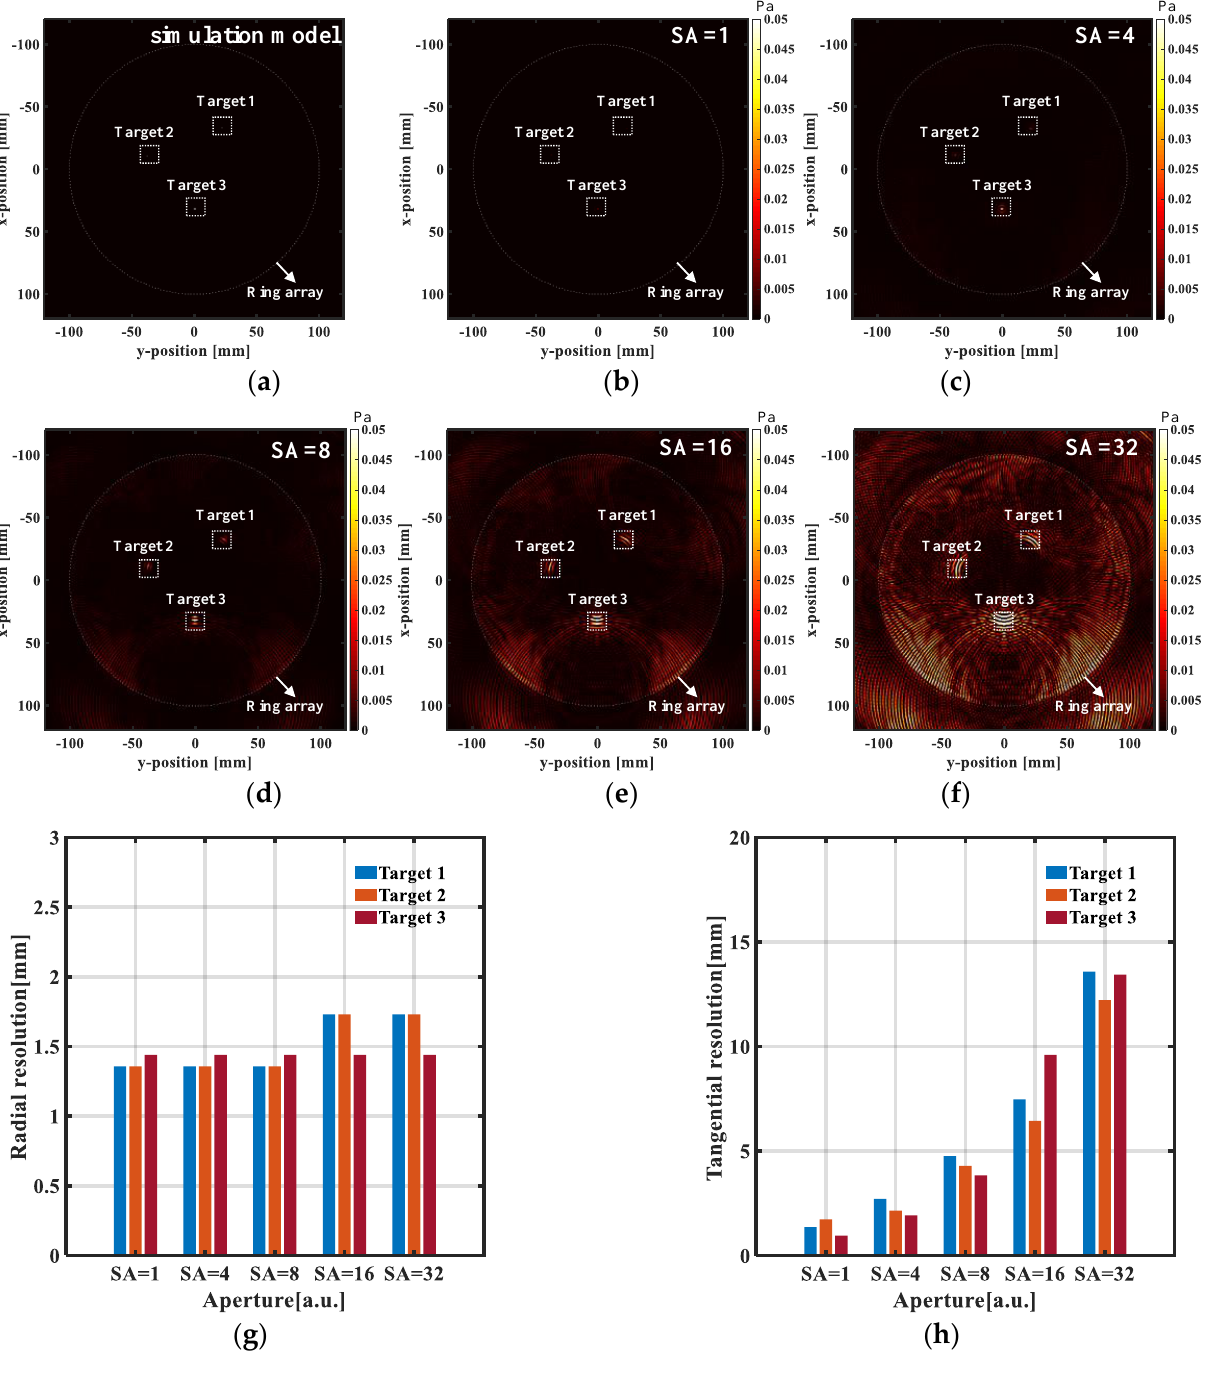
Figure 5. Simulation of the point target with a different aperture (SA = 1, 4, 8, 16, 32). ( a ) Three different targets are built in the simulation model, Target 1 with a radius of 0.25 mm, Target 2 with a radius of 0.5 mm and Target 3 with a radius of 0.75 mm. ( b – f ) The reconstructed US image using the SA method. ( g , h ) Bar chart comparison of the spatial resolution of the three different targets. SA: synthetic aperture.